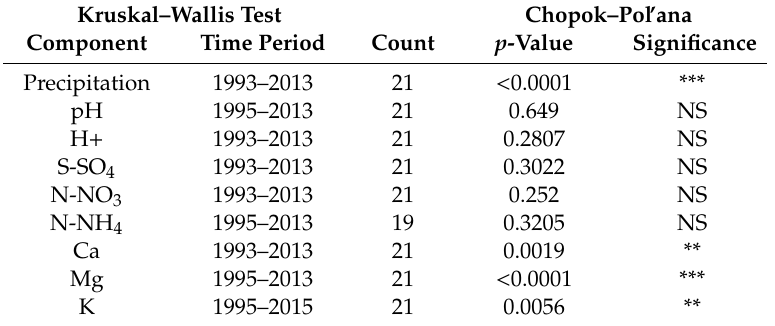
Table 1. Statistical di ff erences between stations Chopok and Pol’ana based on concentrations of elements in precipitation. Kruskal–Wallis Test